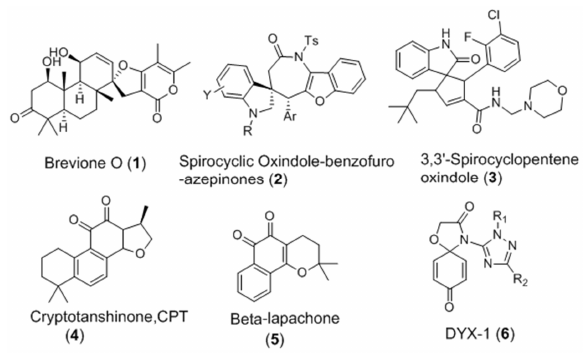
Figure 1. Biologically active spirocyclic and quinone derivatives.